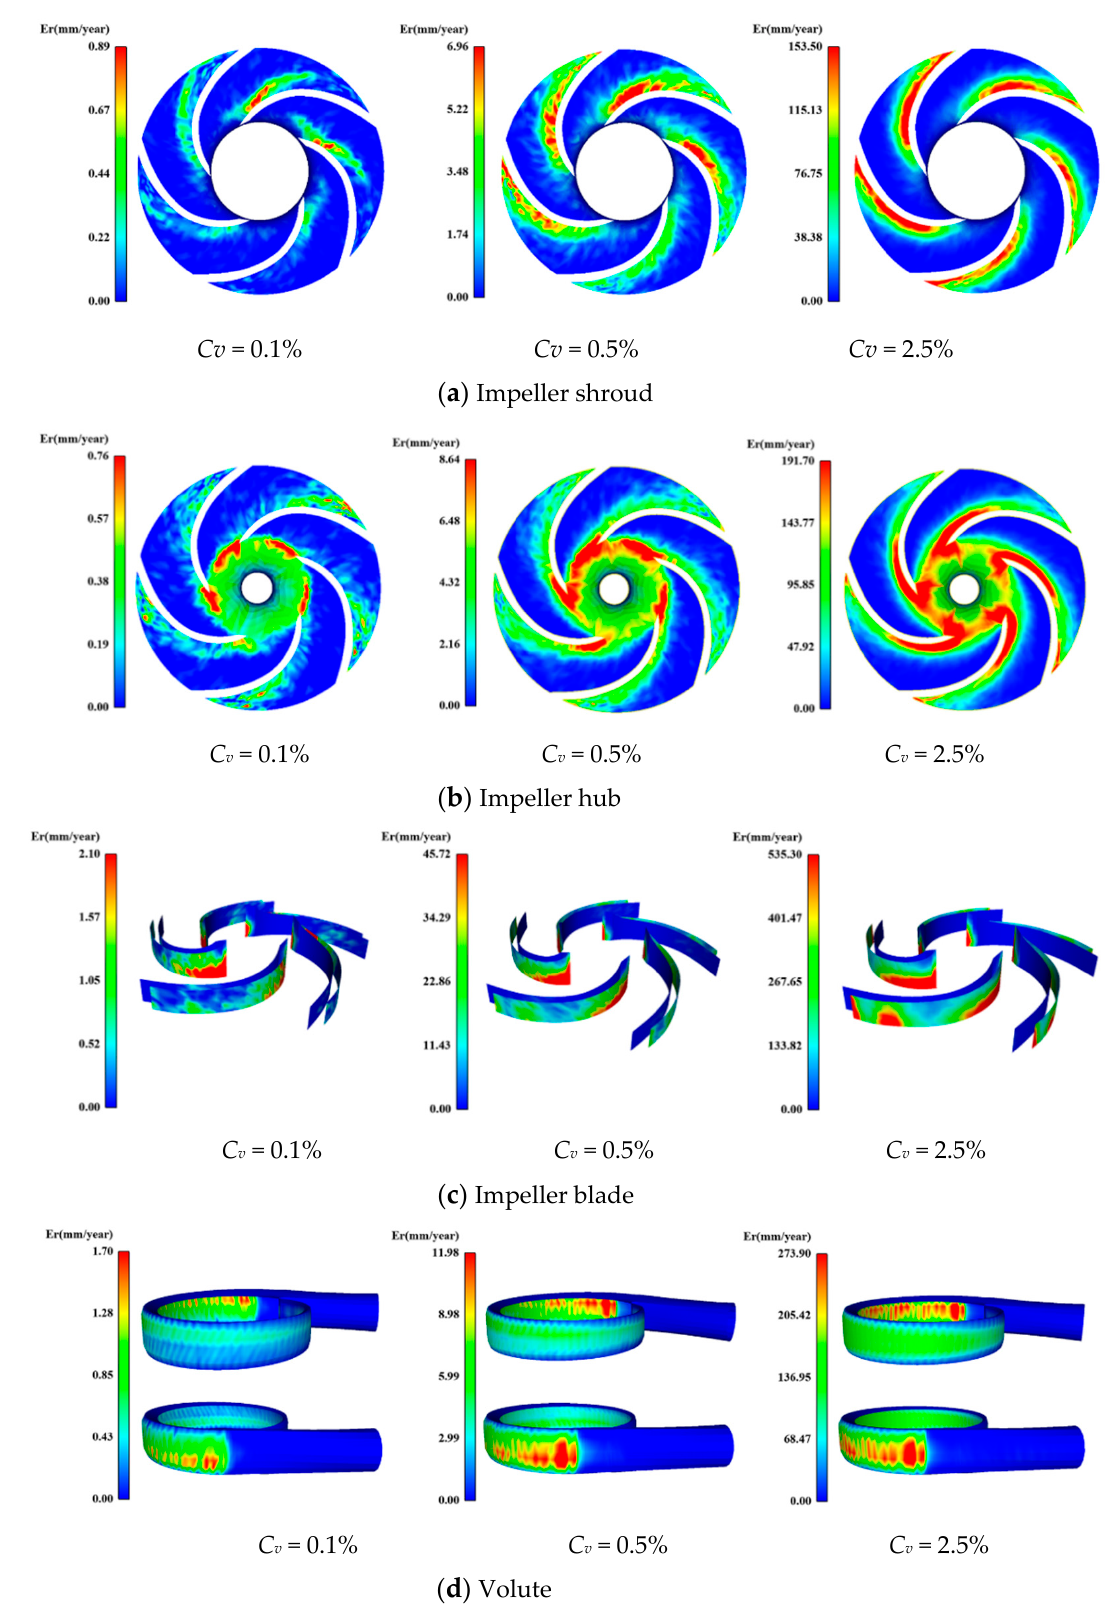
Figure 9. Contours of the predicted annual erosion rate on different components of the pump under different particle volume fractions. ( a ) Impeller shroud; ( b ) Impeller hub; ( c ) Impeller blade; ( d ) Volute.